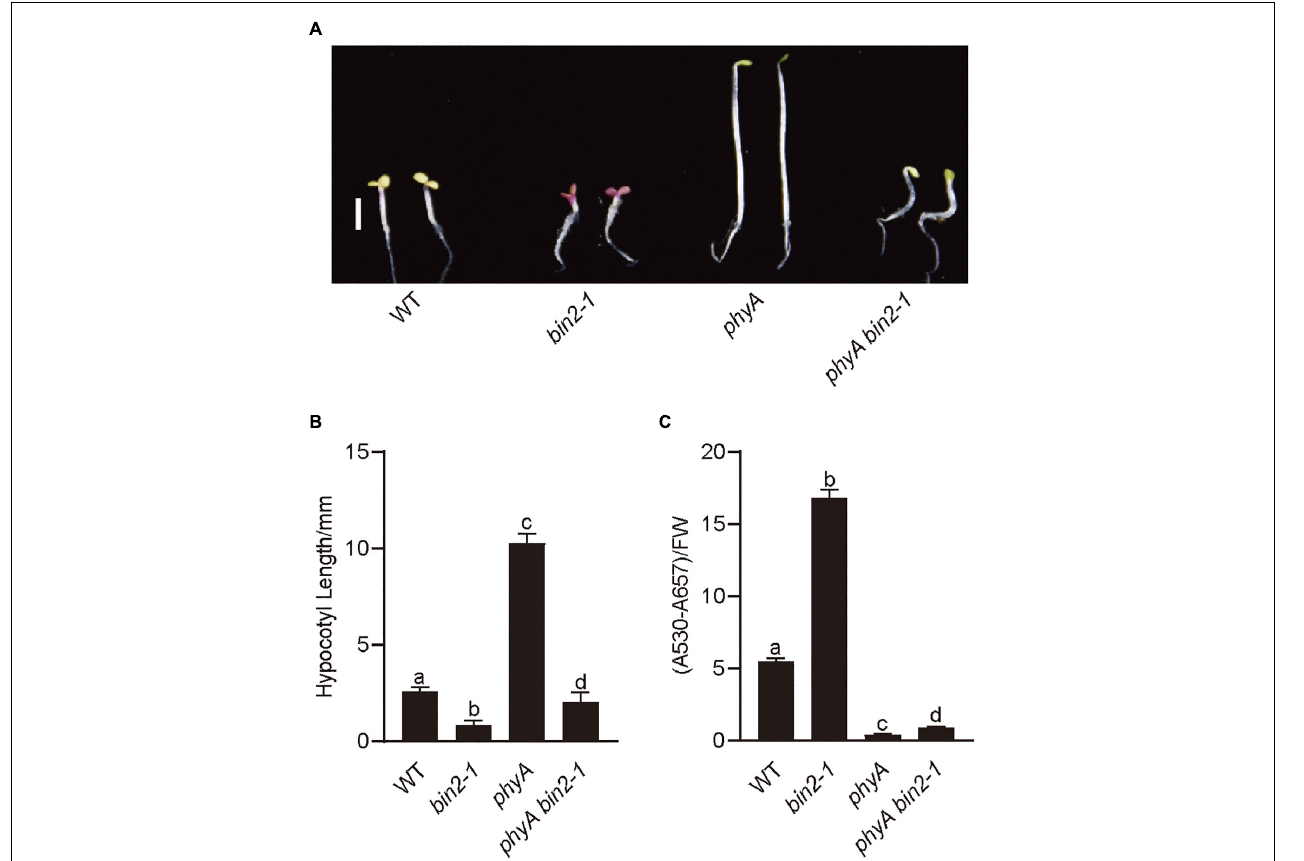
FIGURE 4 | BIN2 acts downstream from PHYA genetically to regulate photomorphogenesis. (A) Phenotypes of bin2-1 and phyA bin2-1 mutant seedlings grown in far-red light (1 µ mol/m 2 /s) for 5 days. Scale bars, 2 mm. (B) Hypocotyl lengths and anthocyanin contents measurements in the genotypes of plants in (A) . Data in (B) is mean ± SD ( n = 30). Data in (C) is mean ± SD ( n = 2). Statistically significant differences are determined by a one-way analysis of variance (ANOVA), followed by Tukey’s least significant difference (LSD) test ( P < 0.05), which are marked by letters “a” to